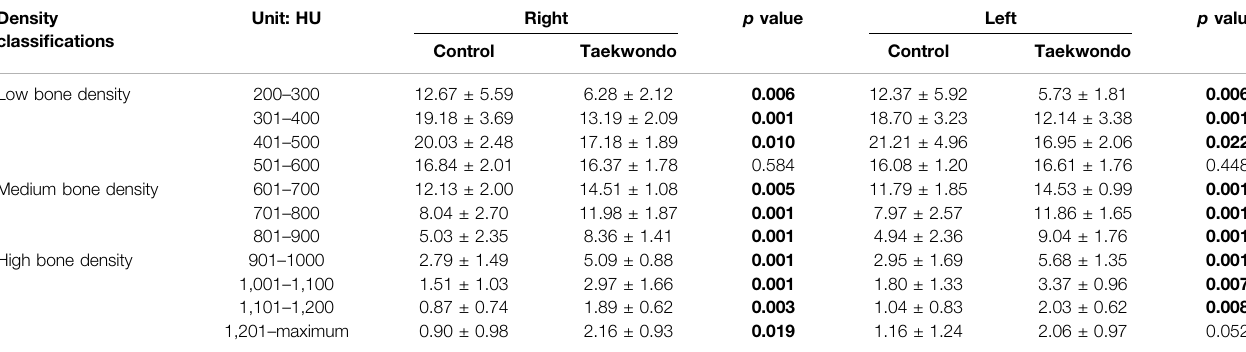
TABLE 4 | Comparison of the bone volume of each bone density zone in the talus subchondral bone between the groups (%). Density Unit: HU Right p value Left classi fi cations Control Low bone